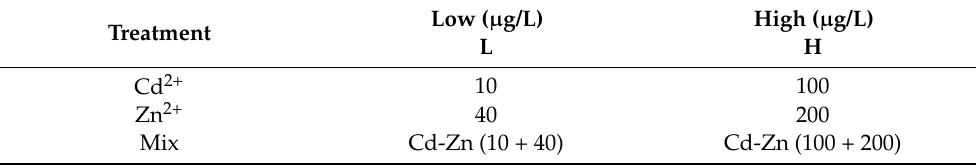
Table 1. Concentrations of considered